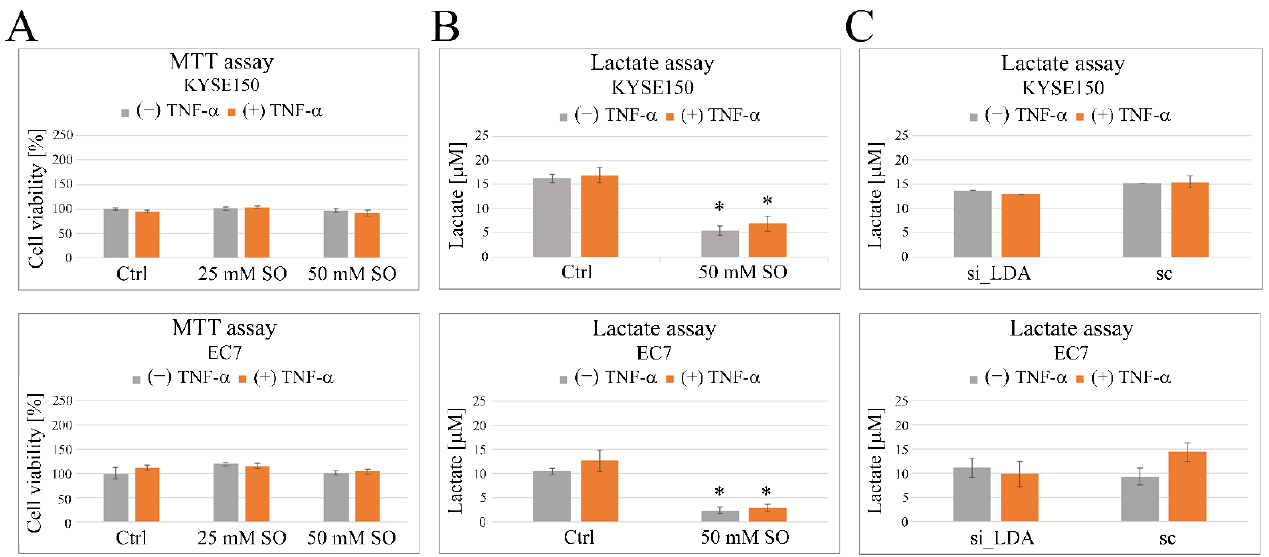
Figure 4. Effect of LDHA inhibition on esophageal cancer cell viability and lactic acid (LA) production. ( A ) The viability of both squamous epithelial cancer cells and cells of adenocarcinoma origin after 48 h exposure to SO at concentrations of 25 mM and 50 mM was measured using the MTT assay. Under the conditions used, SO did not significantly affect the viability of KYSE150 (upper panel) or EC7 (lower panel) cells regardless of whether they were additionally stimulated with TNF- α or not. ( B ) SO effectively inhibited LA secretion in both cell types, regardless of the presence of TNF- α , and the observed differences from the untreated control were statistically significant. ( C ) No statistically significant differences in LA production were observed in both KYSE150 (upper panel) and EC7 (lower panel) cells with siRNA-mediated silencing of LDHA gene expression. Ctrl —